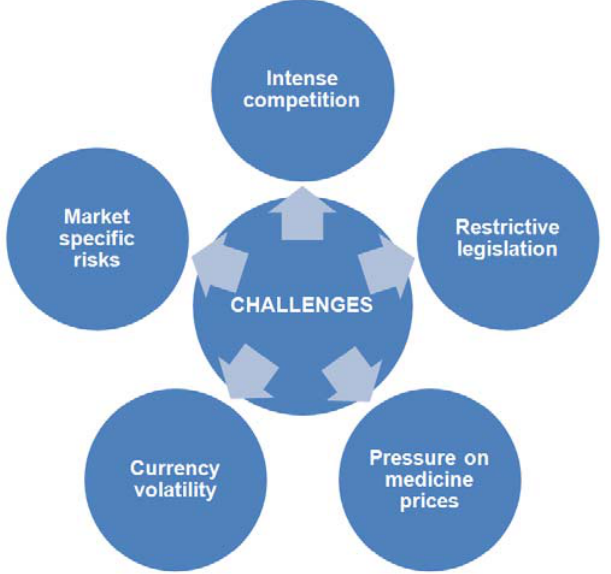
Fig. 2. Aspen “challenge